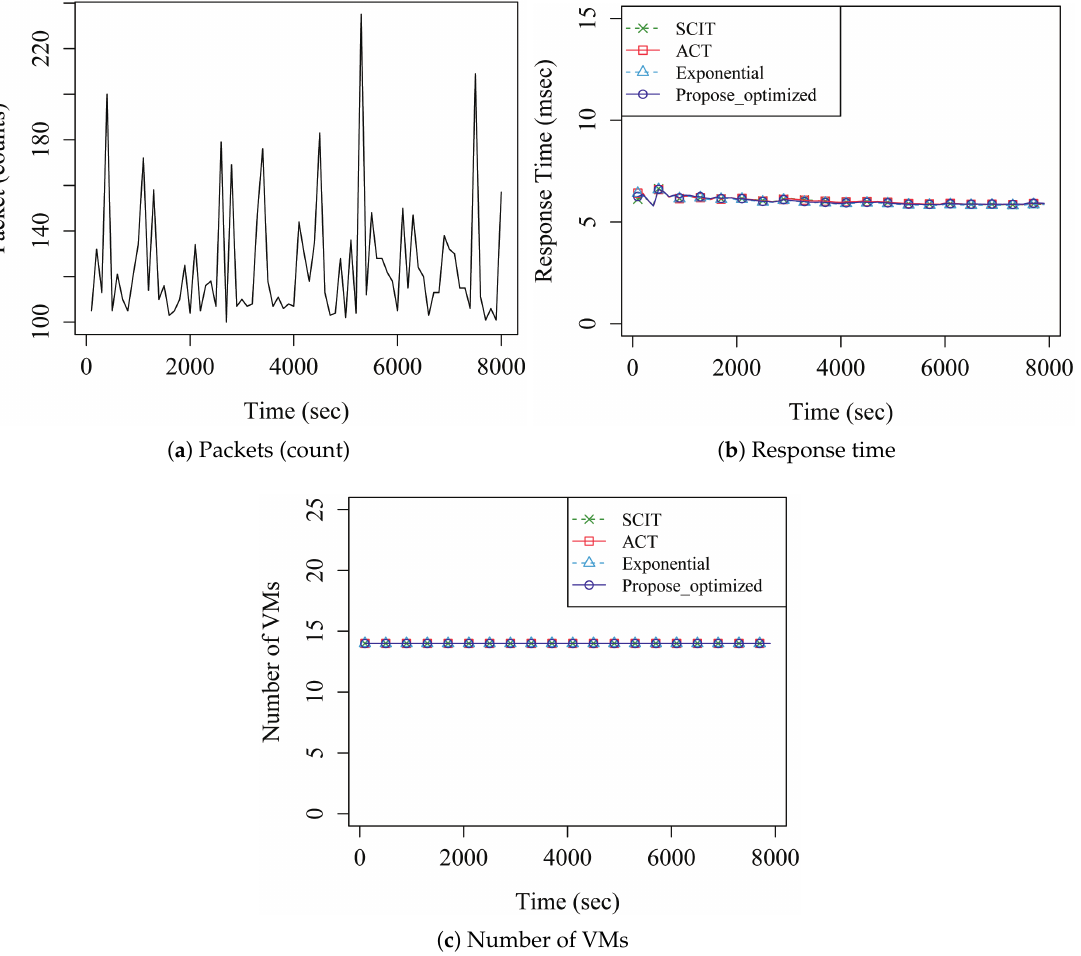
Figure 3. Scenario 1: normal packets. ACT: adaptive cluster transformation. ( a ) packets (count); ( b ) response time; ( c ) number of